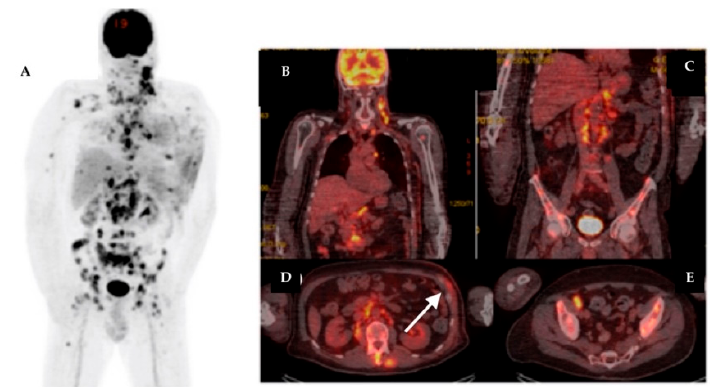
Figure 3. Male patient with left breast cancer and multiple metastatic lesions. Synchronous confirmed Hodgkin lymphoma. MIP image on F18-FDG PET/CT ( A ); coronal section at thorax level showing multiple cervical and mediastinal pathologic lymph nodes, with increased F18-FDG uptake ( B ); coronal section at abdominal level showing multiple pathologic lymph nodes with increased F18-FDG uptake in retroperitoneal area and multiple bone lesions, confirmed as metastatic from breast cancer ( C ); axial section at upper abdominal level showing multiple pathologic lymph nodes with increased F18-FDG uptake in retroperitoneal area and multiple bone and muscle lesions ( D ) and infiltration of left breast area posttherapy, with recurrence of the tumor (white arrow); axial section at pelvic level showing pathologic lymph node with increased F18-FDG uptake in right external iliac area and multiple bone lesions ( E ).